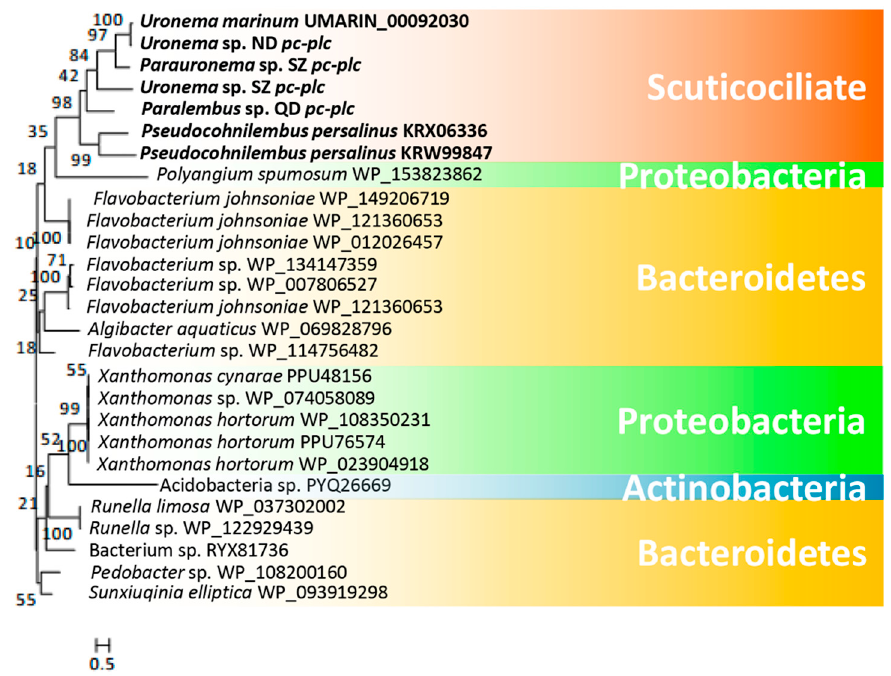
Figure 7. Phylogenetic tree of pc-plc genes in scuticociliates and bacteria. pc-plc genes were identified in all scuticociliates. The top 20 prokaryotic BLASTP hits (using the encoded U. marinum PC-PLC proteins as the seed sequence) in the NCBI non-redundant protein database were used to construct the phylogenetic tree.